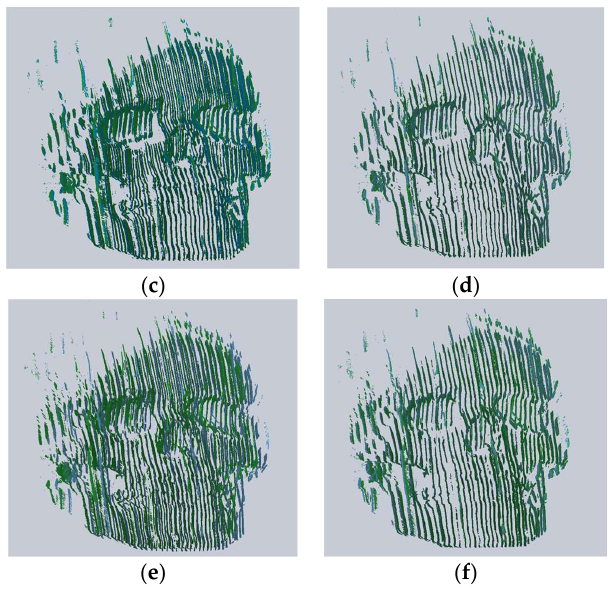
Figure 7. Visualization before and after applying the ICP algorithm ( a , b ) for first pair, ( c , d ) for 2nd pair and ( e , f ) for 3rd pair. Table 2. RMS for the ICP algorithm applied for three pairs of roughly registered point clouds.